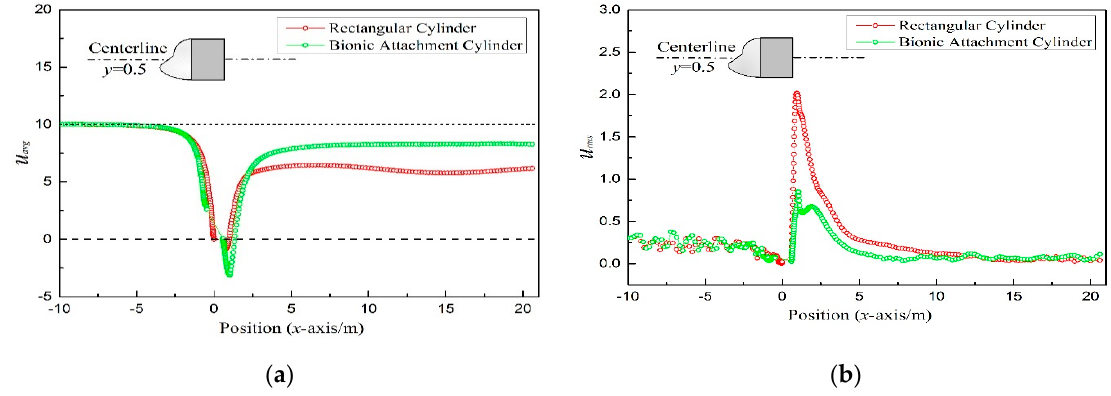
Figure 9. Distributions of stream-wise velocity along the centerline of the structure. ( a ) Time-average velocity and ( b ) root-mean-square velocity.